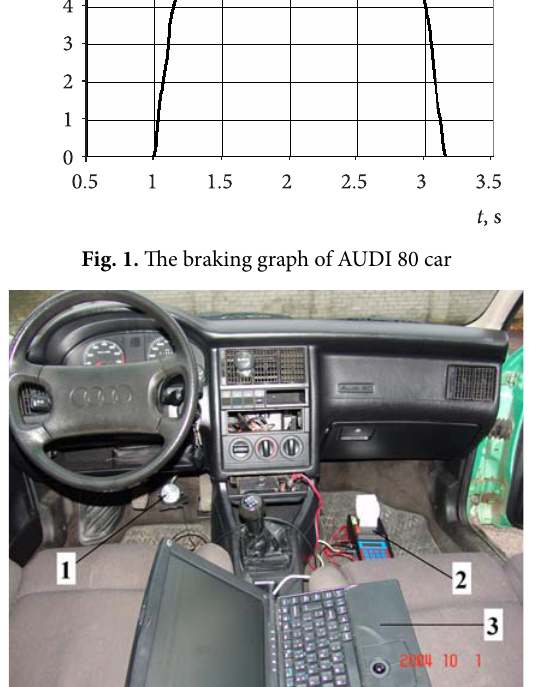
Fig. 2. Location of the experimental equipment inside the car: